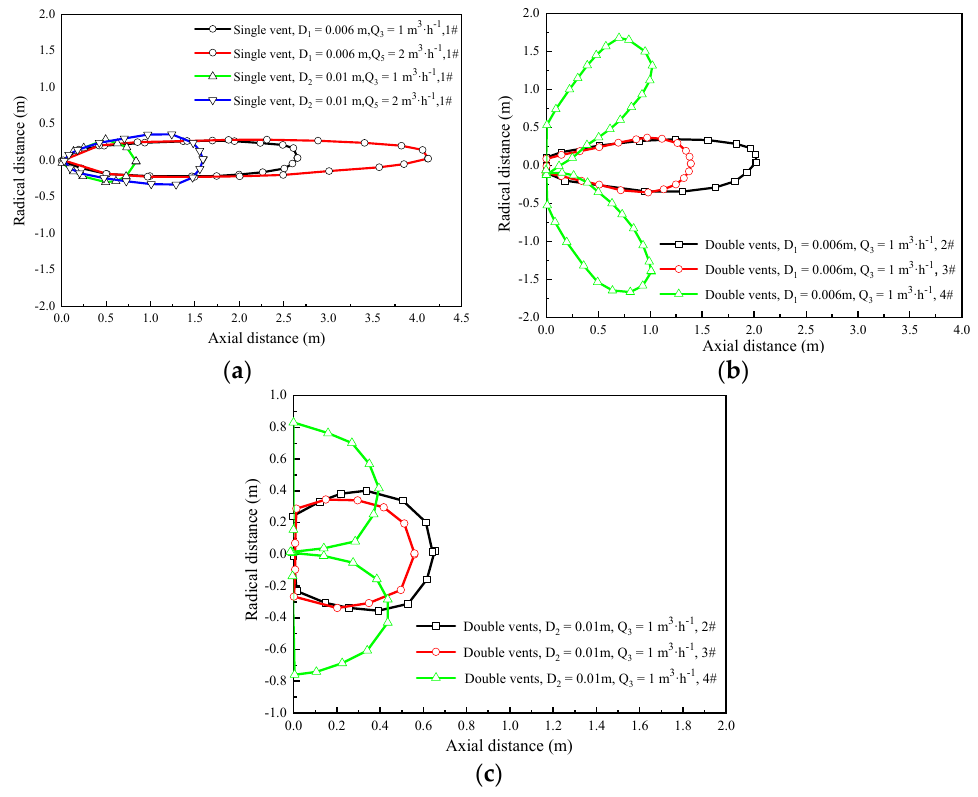
Figure 8. Oxygen-enriched area with different oxygen supply vents and oxygen supply mode in un-air-conditioned state. ( a ) 1#, ( b ) 2#, 3#, 4# (D 1 = 0.006 m), ( c ) 2#, 3#, 4# (D 2 = 0.01 m).